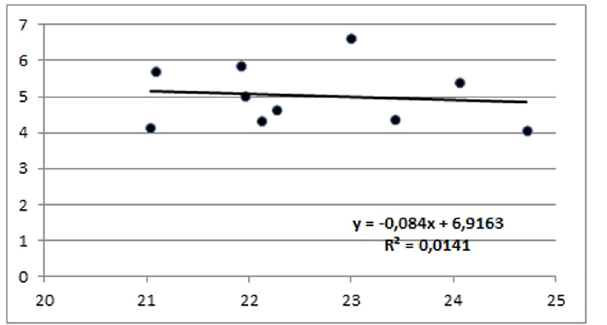
Figure 3: Linear approximation of the dependence of the meat content on the fat content in the dorsal - lumbar third of the carcass at a slaughter weight of 120 kg.